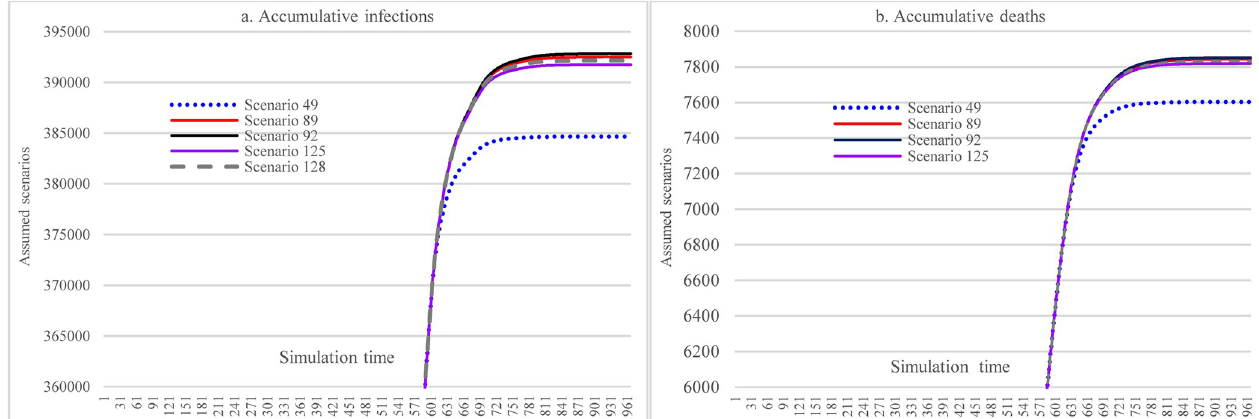
Fig 22. Implementing stringent SDMs versus less stringent SDMs and increased vaccination levels under the mask-wearing adherence level of 70%.